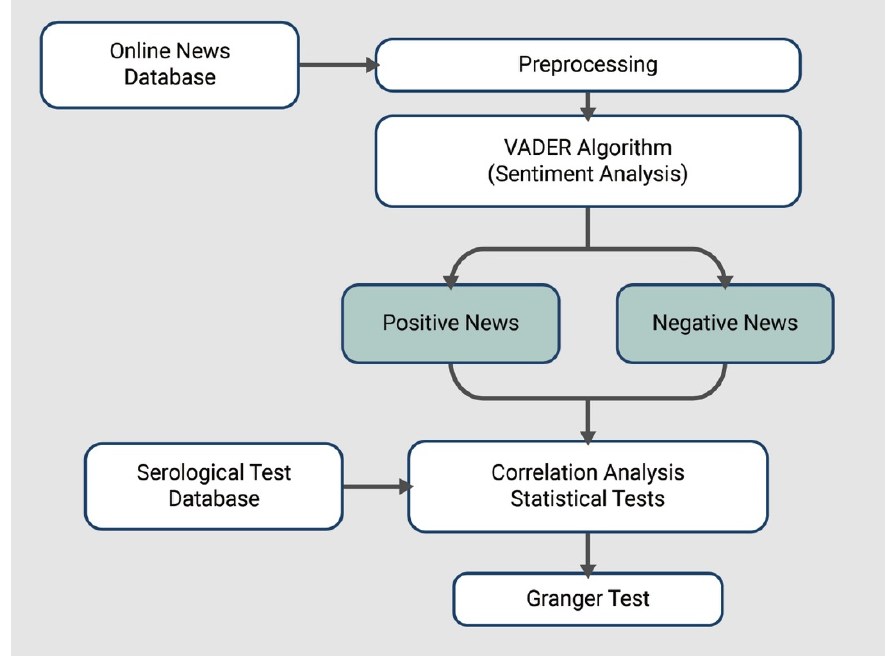
Figure 1. Sequence of stages carried to the classification of each news in their sentiment polarity, as well as the correlation evaluation and Granger Causality